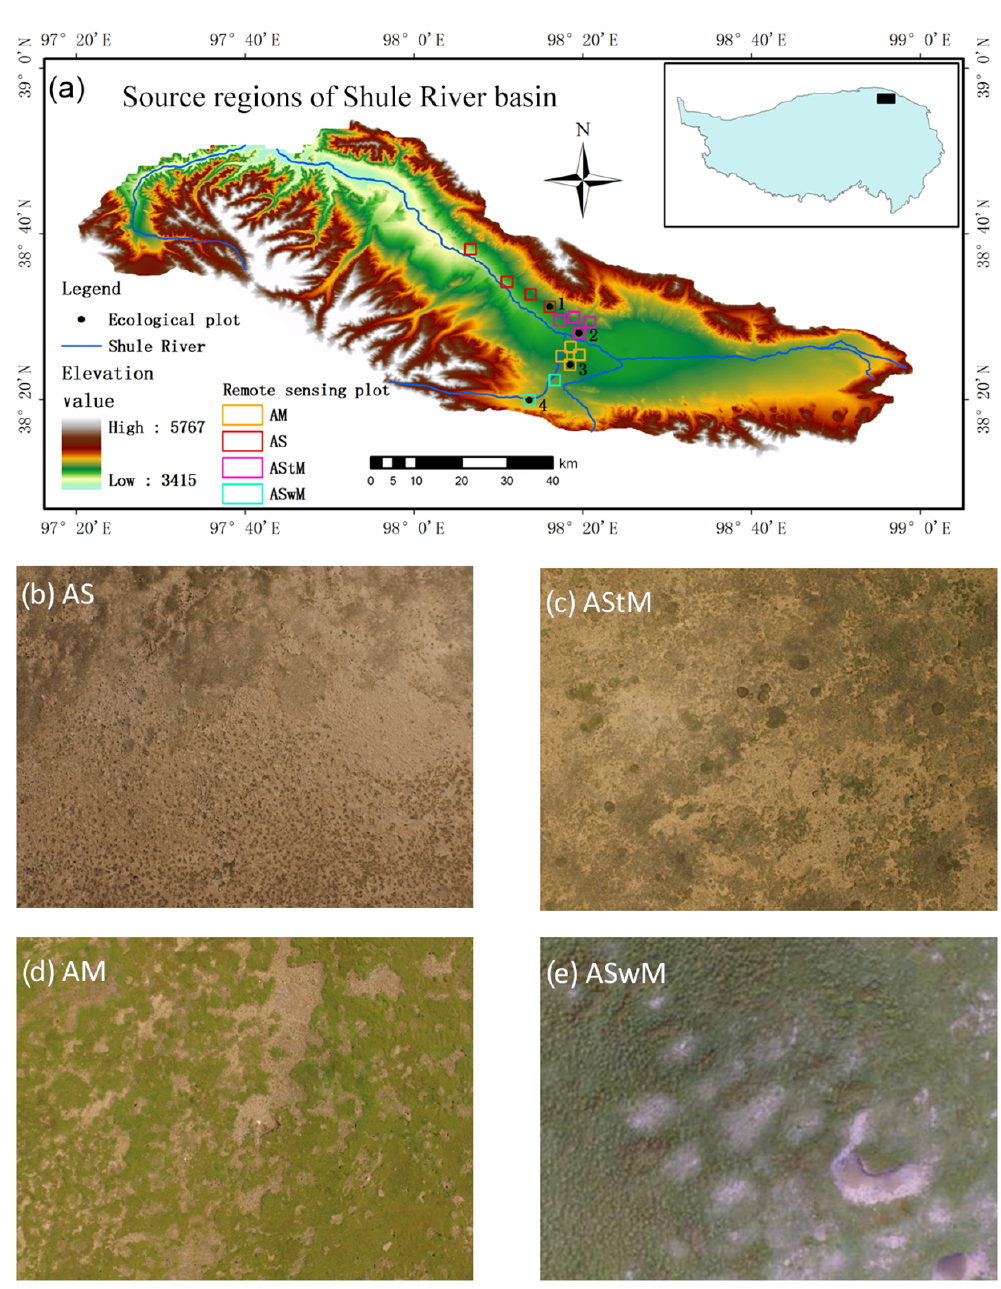
Figure 1. (a) Source region of the Shule River basin and its location in the Qinghai-Tibet Plateau. The rectangles indicate the locations of autopilot flights (each with 12 way points), 1–4 indicate the location of field sampling on each type of grassland; (b) – (e) show aerial photographs of four types of alpine grasslands (AS: alpine steppe; AStM: alpine steppe meadow; AM: alpine meadow; and ASwM: alpine swamp meadow) investigated in this study. Each photograph covers ∼ 35m × 26m ground